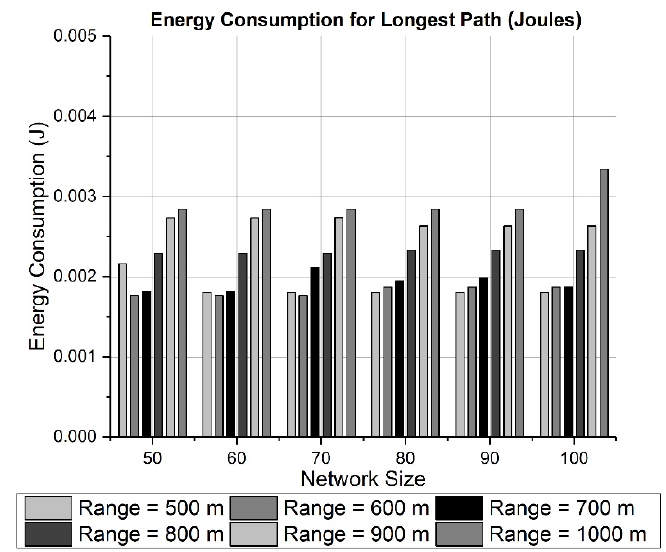
Figure 13. Energy consumption for the longest path (2000 × 2000 × 500 m).